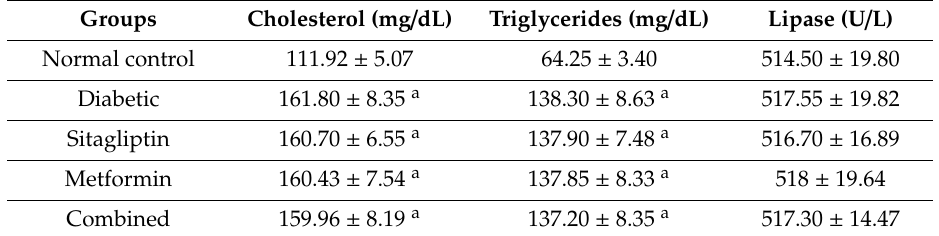
Table 4. Baseline values (before the beginning of treatment) of the lipid profile parameters and serum lipase in the di ff erent studied groups.